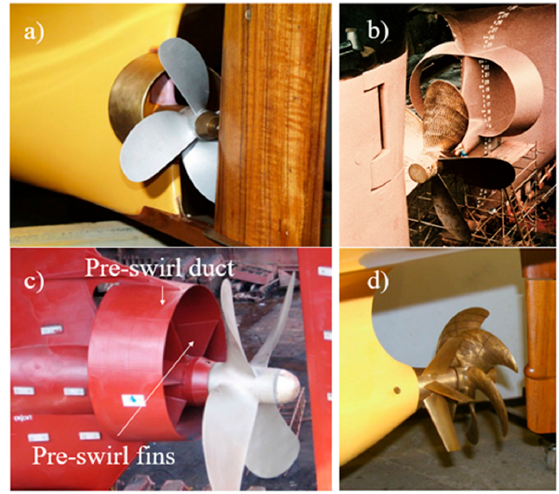
Figure 8. Existing propeller flow conditioning ESDs: ( a ) SILD duct (reproduced with permission from [90]; copyright HSVA, published by Symposium of Marine Propulsors), ( b ) Schneekluth Duct (reproduced with permission; copyright Schneekluth), ( c ) Mewis Duct (reproduced with permission; copyright Becker Marine Systems), and ( d ) Pre-swirl Fins (reproduced with permission from [90]; copyright HSVA, published by Symposium of Marine Propulsors).